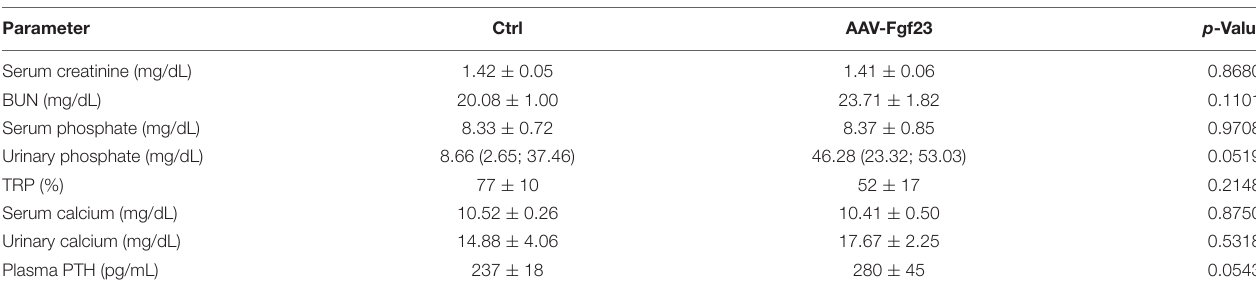
FIGURE 5 | Adeno-associated virus expressing murine Fgf23 mice do not show any signs of pathological LVH. (A) Representative cross-sections of AAV-Fgf23 and Ctrl mice stained with HE (original magnification × 10). (B) Representative cross-sections of AAV-Fgf23 and Ctrl mice stained and wheat germ agglutinin (WGA) (original magnification × 40; scale bar, 50 µ m). (C) Quantification of at least 100 individual cardiac myocytes per mouse reveals no size differences between both groups. (D) As analyzed by quantitative real-time PCR, cardiac Fgfr4 mRNA expression is significantly enhanced in AAV-Fgf23 mice compared to Ctrl. (E) The pro-hypertrophic NFAT target genes BNP , bMHC , Rcan1 , and Trpc6 are not induced in AAV-Fgf23 mice compared to Ctrl. (F) Representative images of picrosirius red-stained mid-chamber free-wall of AAV-Fgf23 and Ctrl mice (original magnification, × 63; scale bar, 50 µ m). (G,H) The mRNA and protein expression of fibrosis-associated markers Tgfb1, Col1a1, and Ctgf and are not altered in AAV-Fgf23 mice. Gapdh serves as the loading control. Data are given as scatter dot plots with means; *** p < 0.001 analyzed using Mann–Whitney test according to D’Agostino and Pearson’s normality test; n = 6–14 mice per group. TABLE 1 | Kidney function and mineral metabolism in AAV-Fgf23 and control